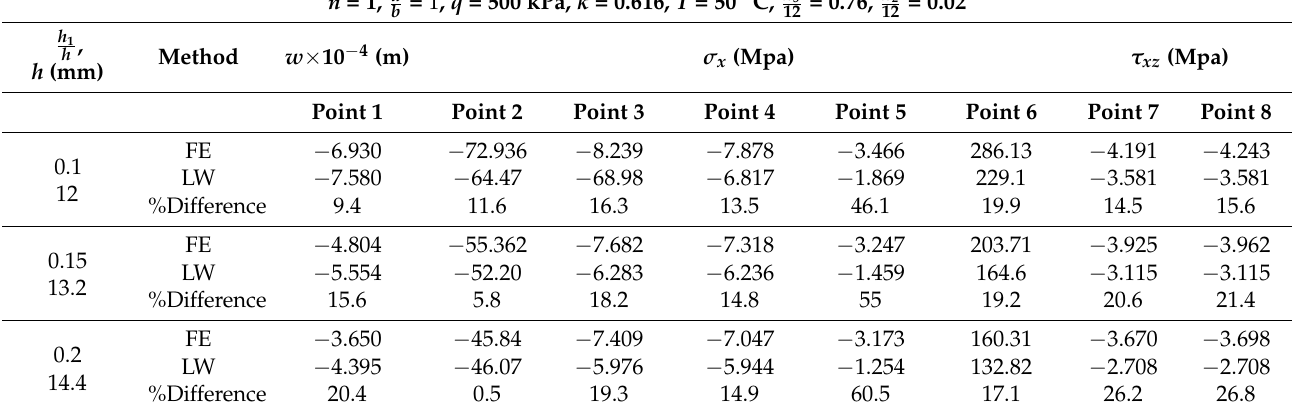
Table 11. Comparison of the result based on LT and those FE